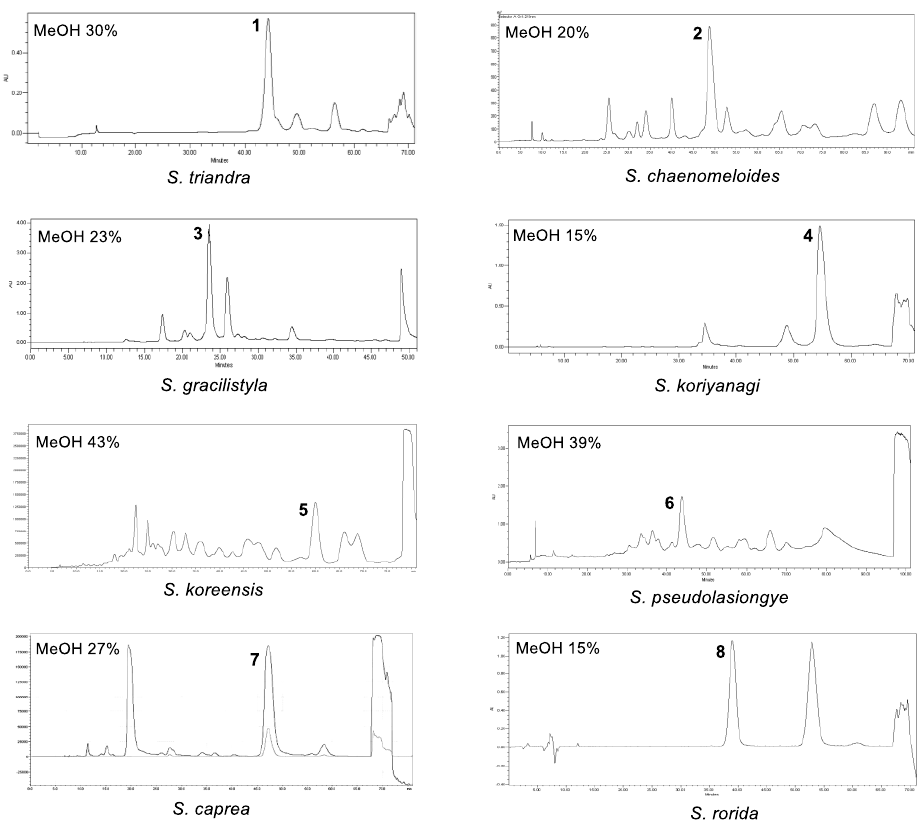
Figure 3. HPLC chromatogram for isolation of marker compounds 1–8 from the eight collected Salix species.